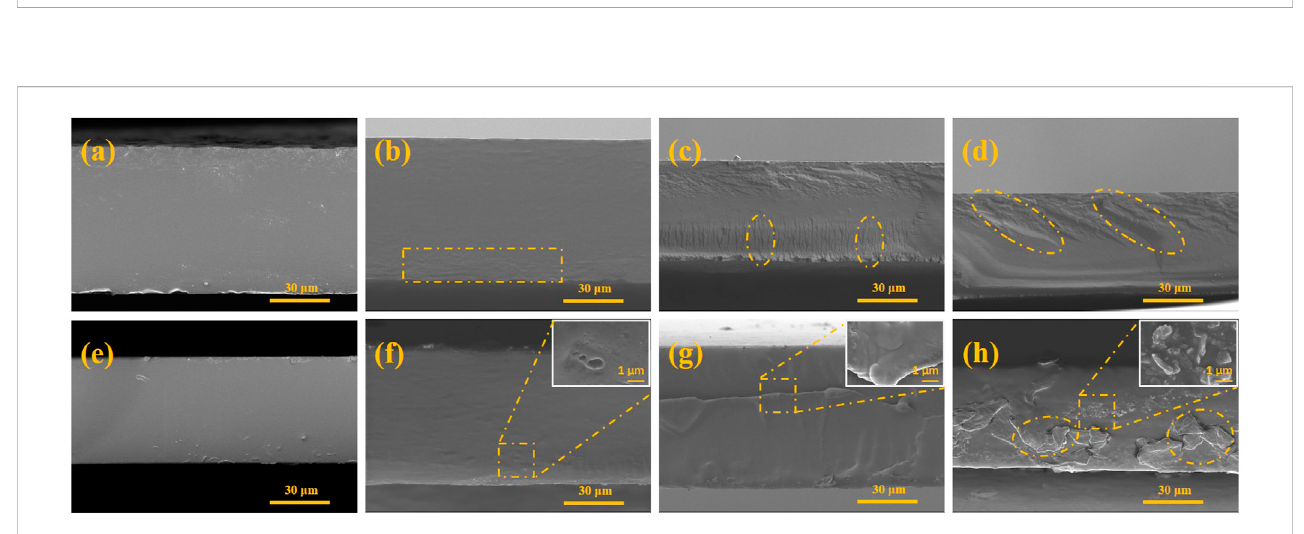
Stress-straincurveand the tensile strength with theelongation atbreak ofthe starch/CMC composite fi lms. (A, C) : CS/CMC composite fi lms; (B, D) :CA/ CMC composite fi